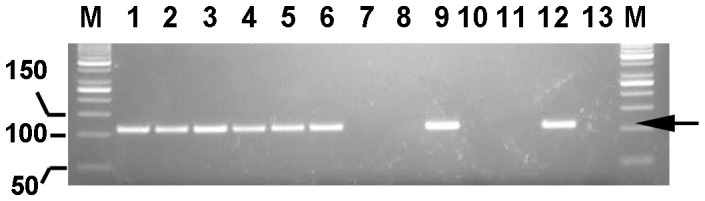

mRASSF1A-PAP serial dilution range of gDNA from CVS.Serial dilutions were performed with gDNA from CVS in a background of 1000(pg) mentioned is the total amount of fetal gDNA. M = 50 bp marker, 1 = 1000 pg, 2 = 500 pg, 3 = 250 pg, 4 = 125 pg, 5 = 60 pg, 6 = 30 pg, 7 = 15 pg, 8 = 7 pg, 9 =  positive control for bisulfite conversion, 10 = NTC for bisulfite conversion, 11 =  negative control for bisulfite conversion (non-bisulfite converted fetal gDNA), 12 =  positive control for mRASSF1A-PAP, 13 = NTC for mRASSF1A-PAP. A 110 bp product (arrow) is obtained in cases where mRASSF1A sequences could be detected using mRASSF1A-PAP.